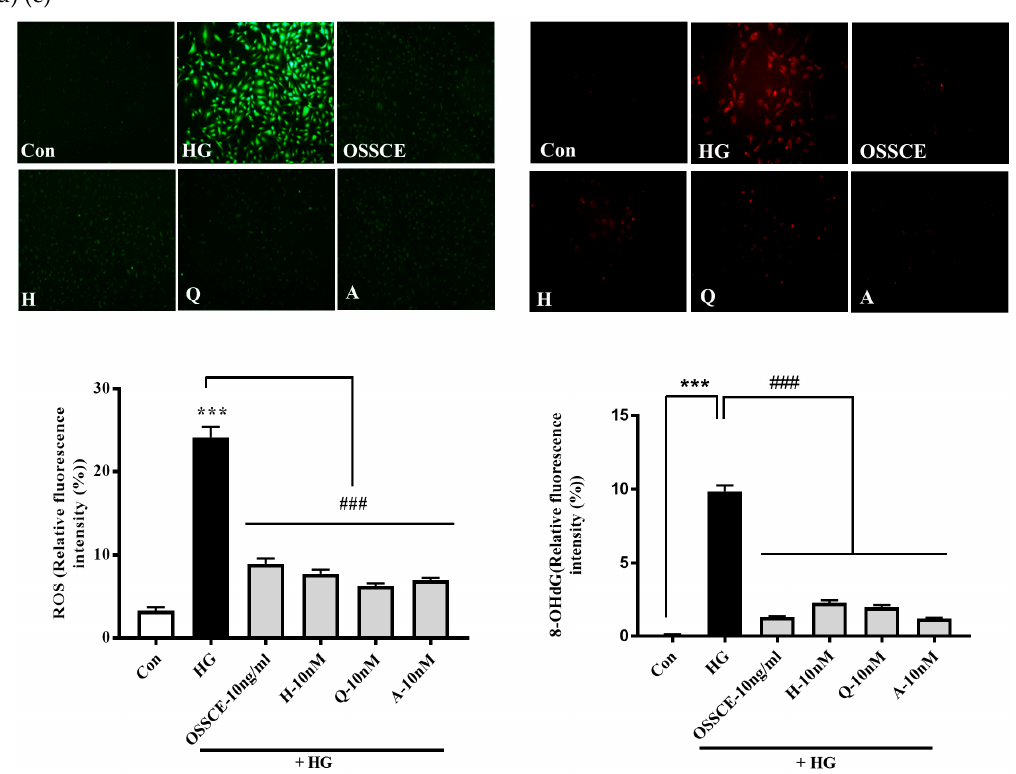
Figure 3. OSSCE inhibits retinal apoptosis in SDT rats, as well as ROS generation and 8-OHdG expression in HG-treated HRMECs: ( a ) The OSSCE-treated groups reduce apoptosis in retinal ganglion cells and in ( b ) retinal microvascular vessels. The retinal sections and whole mount of retinal microvascular cells from all groups were stained with a terminal deoxynucleotidyl transferase dUTP nick end labelling (TUNEL) kit; then, the TUNEL-positive cells were analysed. *** p < 0.001, ** p < 0.01 vs. NOR; # p < 0.05, ## p < 0.01, ### p < 0.001 vs. SDT. ( c ) The retinal sections in all groups were stained with Bax, Bcl-2, and cleaved caspase-3 antibodies, and their expression levels were measured quantitatively by a western blot. The ratio of Bax to Bcl-2 and the levels of cleaved caspase-3 in SDT rat retinas increased in vehicle-treated SDT rats but were significantly suppressed by OSSCE. ** p < 0.01 vs. NOR; # p < 0.05, ## p < 0.01 vs. SDT ( n = 3–5). ( d ) The intracellular ROS levels were measured by the dihydrodichlorofluorescein diacetate (DCF-DA). The increase observed in HG-treated HRMECs was significantly reversed by treated with OSSCE or MCs. *** p < 0.001 vs. Con; ### p < 0.001 vs. HG. The data are expressed as means ± S.D. ( n = 3). ( e ) The cells were incubated with an 8-OHdG-specific primary antibody and an Alexa Fluor 594 anti-rabbit antibody. The 8-OHdG expression was significantly decreased by treatment with OSSCE or MCs in HG-treated HRMECs. *** p < 0.001 vs. Con; ### p < 0.001 vs. HG. The data are expressed as means ± S.D. ( n =